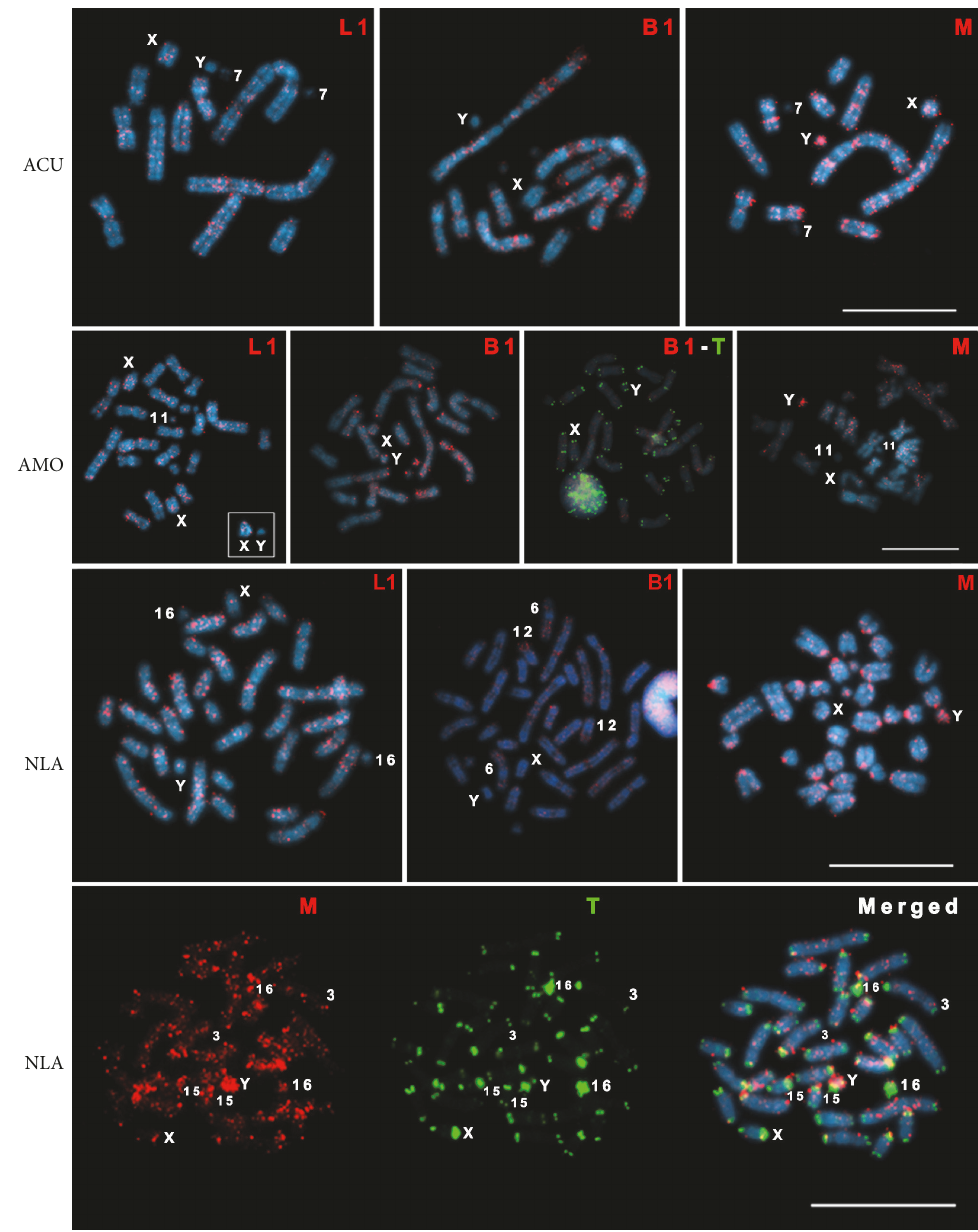
Figure 5: FISH with digoxigenin-labeled transposable elements and biotin-labeled telomeric sequences in cells of Akodontini. ACU: Akodon cursor ; AMO: A. montensis ; NLA: Necromys lasiurus ; L1: LINE-1; B1: B1 SINE; M: mysTR, T: telomere sequence. The cells of AMO depicted are of a female and the sex chromosomes of a male are shown in the inset. Bar=10 μ